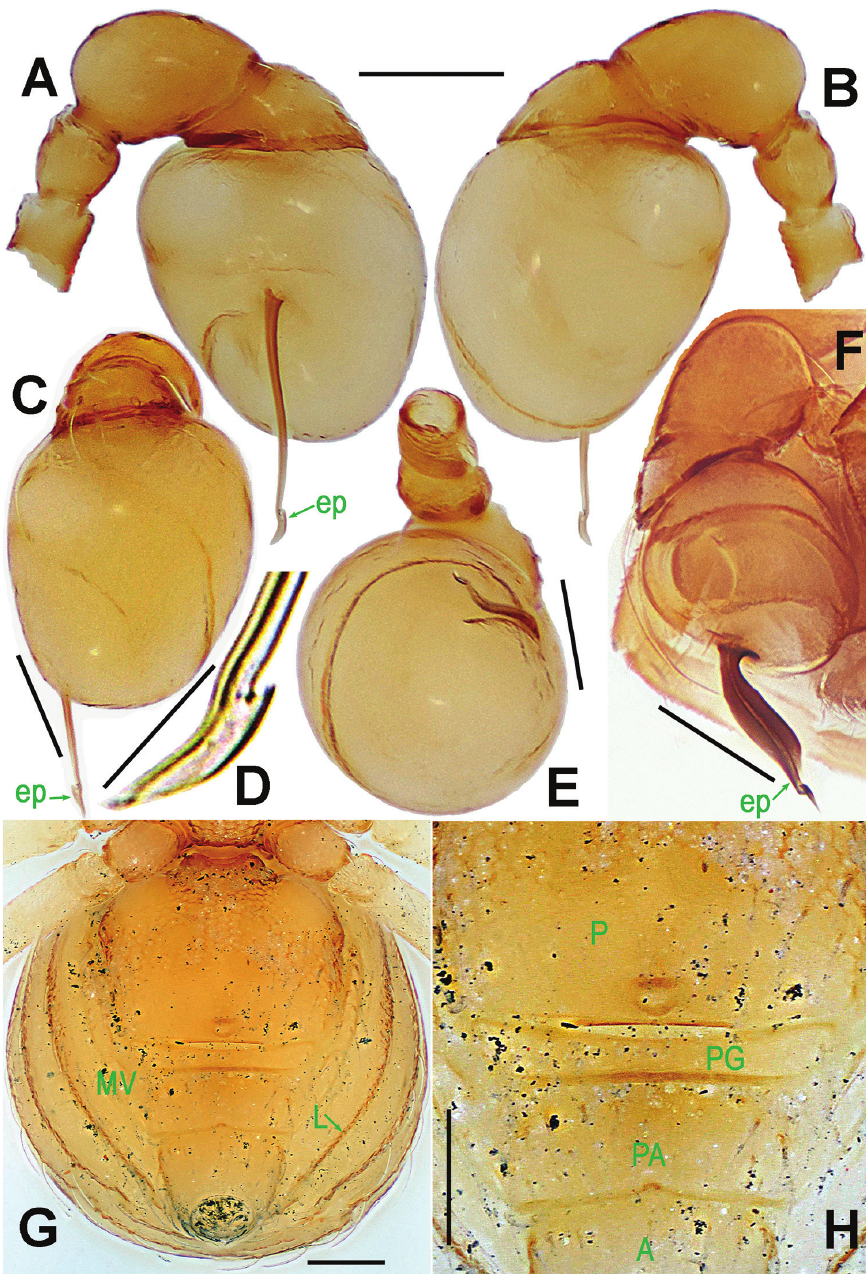
Figure 23. Singaporemma singulare Shear, 1978, male holotype ( A–E) and female paratype (G–H ), and S. adjacens Lehtinen, 1981, male holotype ( F ). A–C, E–F left palp D embolic end G opisthosoma H Gen- ital area (untreated). A, D prolateral B, F retrolateral C anterior E, G–H ventral. Abbreviations: A = anal plate; ep = embolic part of apes of palpal organ; L = lateral plate; MV = median ventrolateral plate; P = pulmonary plate; PA = preanal plate; PG = postgenital plate. Scale bars: 0.10 mm, D 0.05 mm